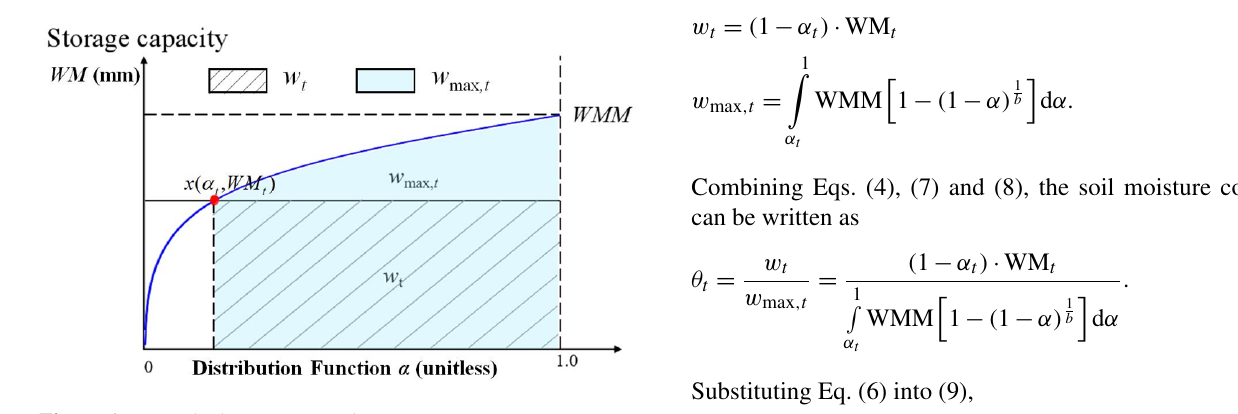
Figure 1. Watershed storage capacity